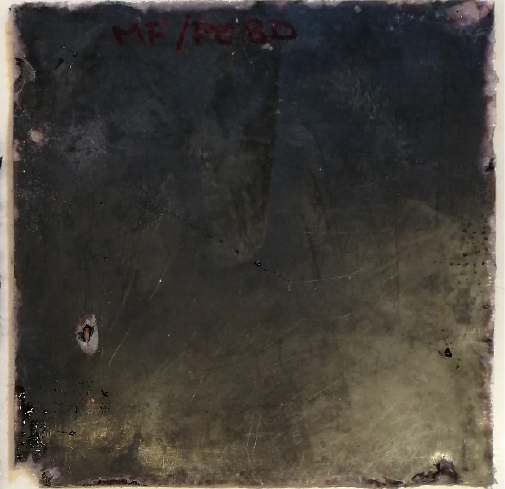
Figure 1. Composites made with 10% vol. of PES-MFs in an LDPE matrix. The lighter section of the photo is a visual effect of the incident light.